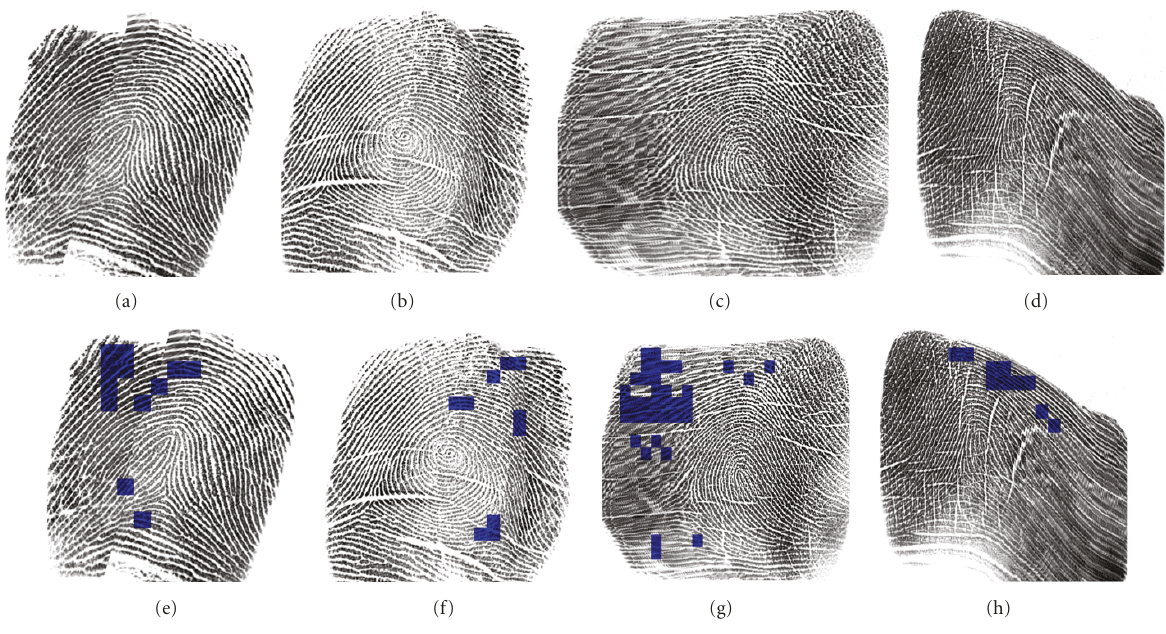
Figure 12: DCT-based smear detection